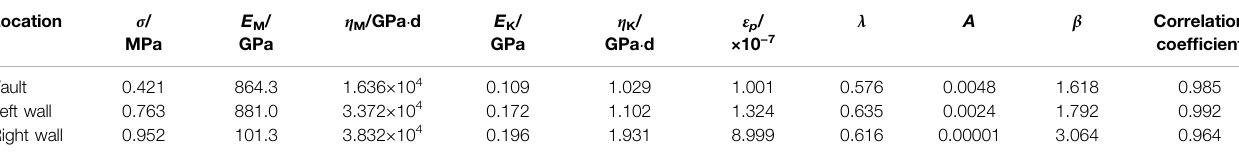
TABLE 5 | Fitting parameters of formulas 3 and 4 in the damp state.